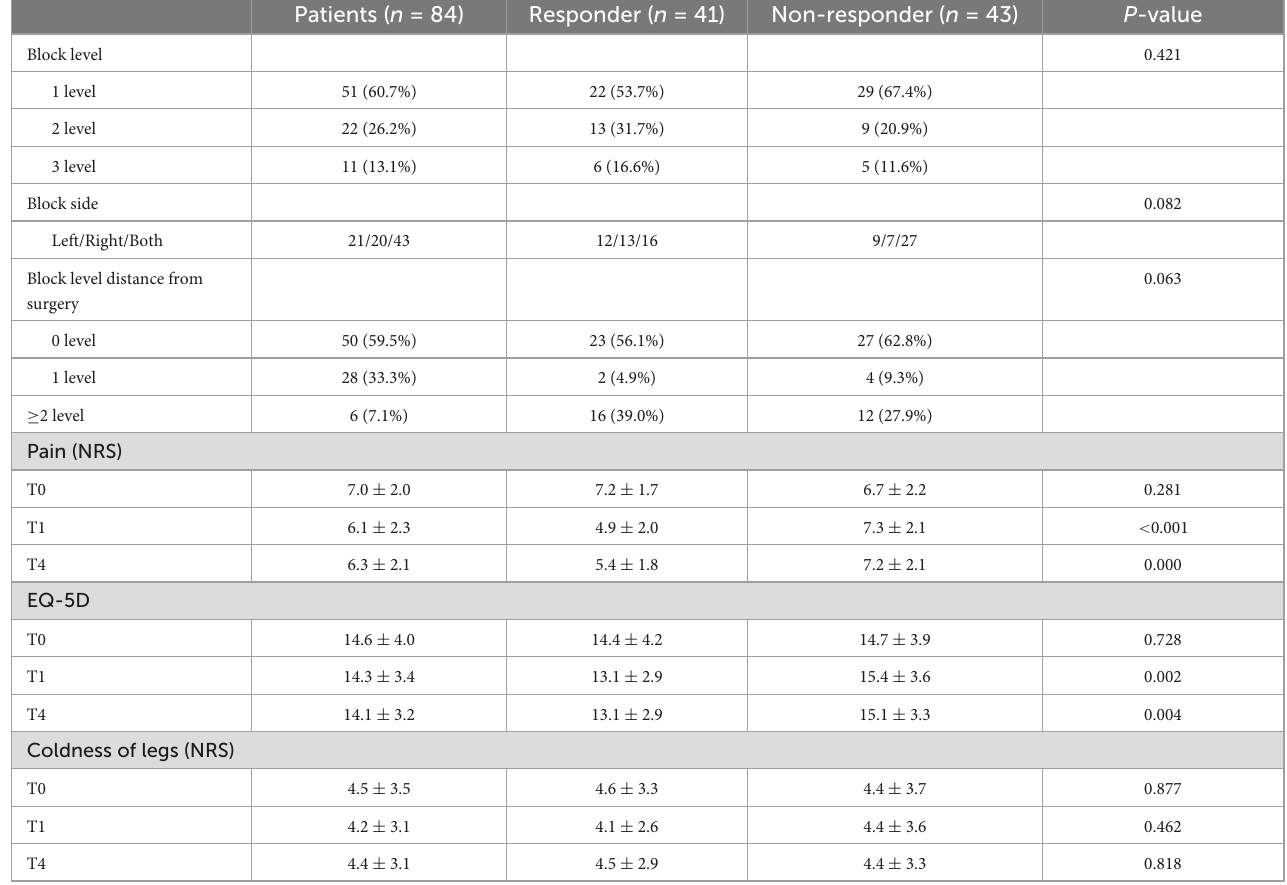
T0 was significantly different ( P = 0.046). In the non-responder group, EQ-5D and coldness of the leg scores did not differ over time ( Table 4 ). Table 5 shows the clinical outcomes over time between the groups. The pain difference between T1 and T0 and T4 and T0 was significantly higher in the responder group ( P < 0.001,